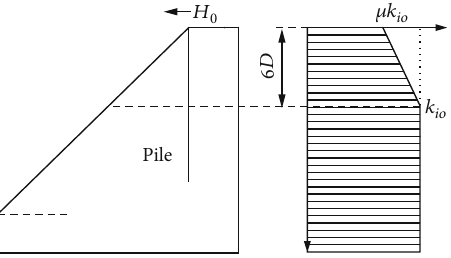
Figure 5: The de fi nition of height di ff erence X .